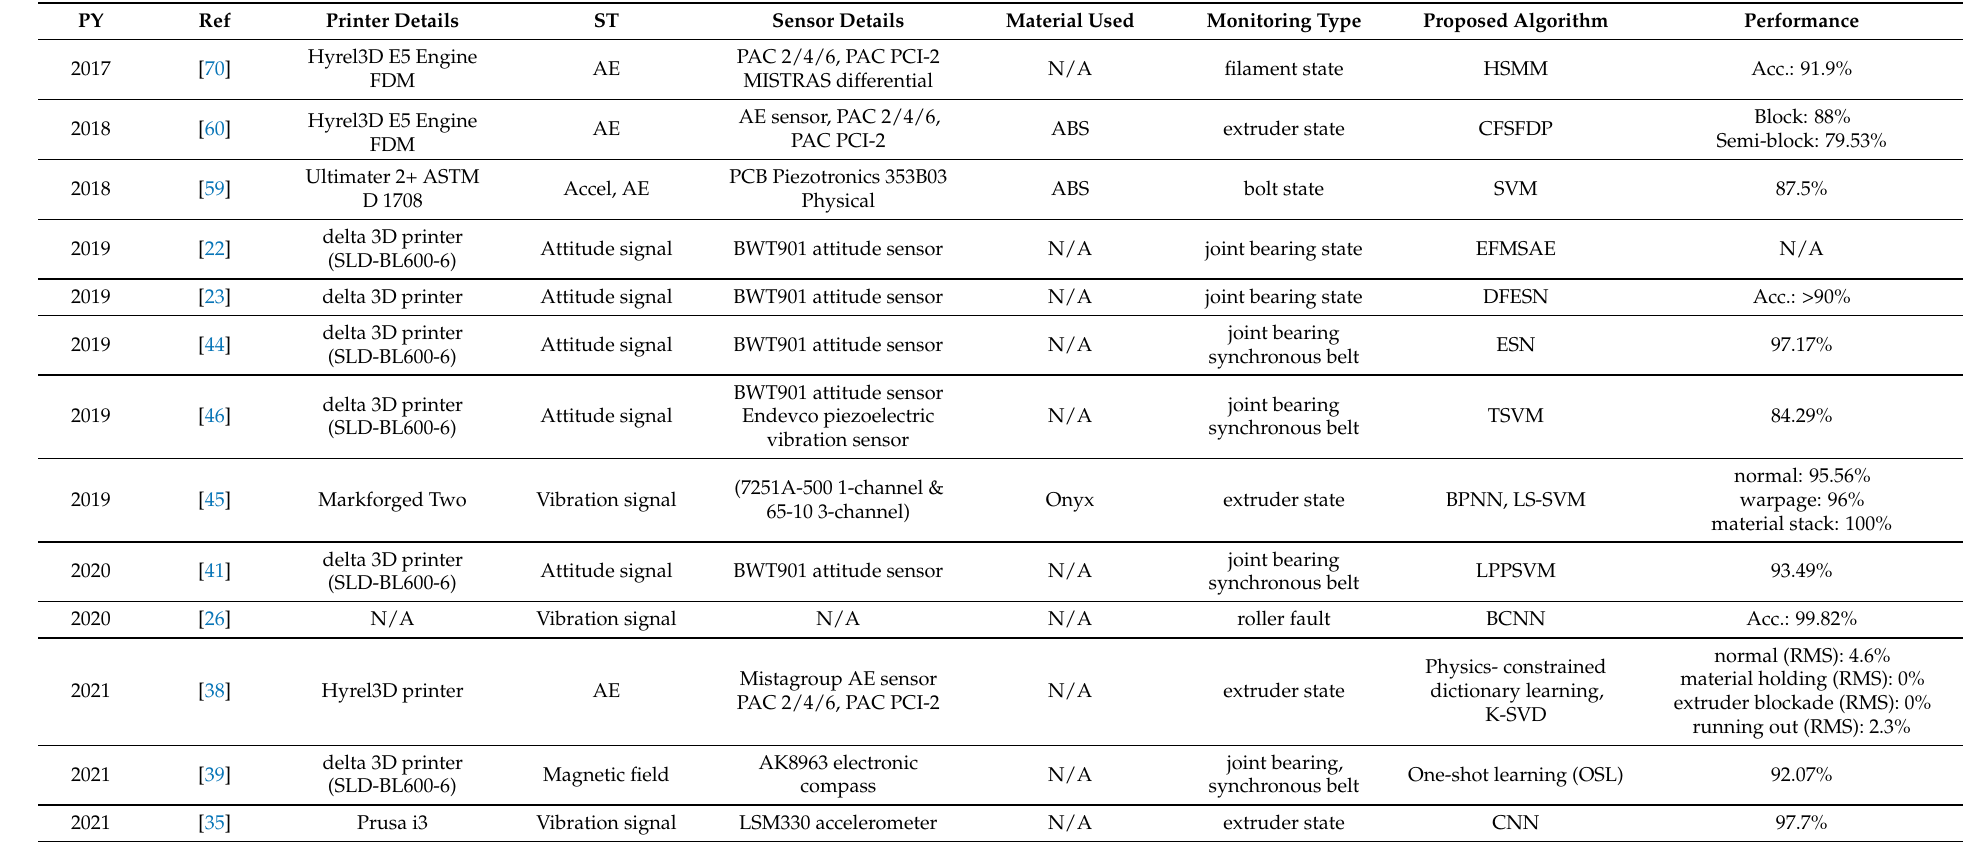
Table 2. Method Summary and Equipment Details of Mechanical Fault Diagnosis